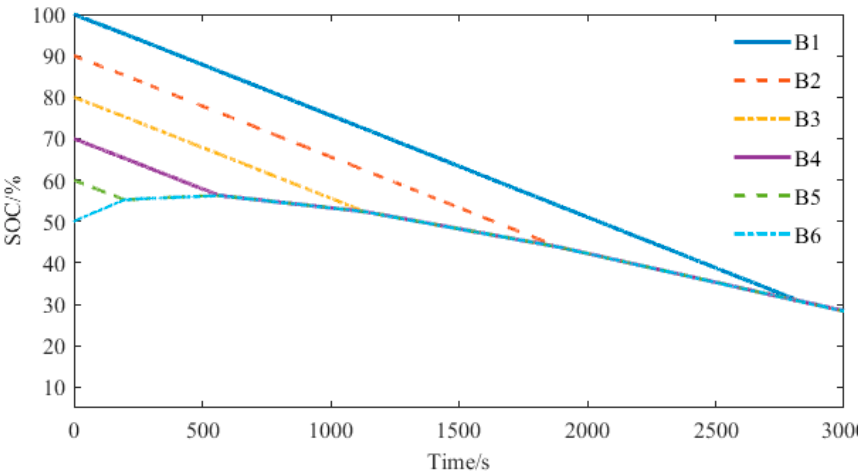
Figure 17. Equilibrium results of filling valley scheme.